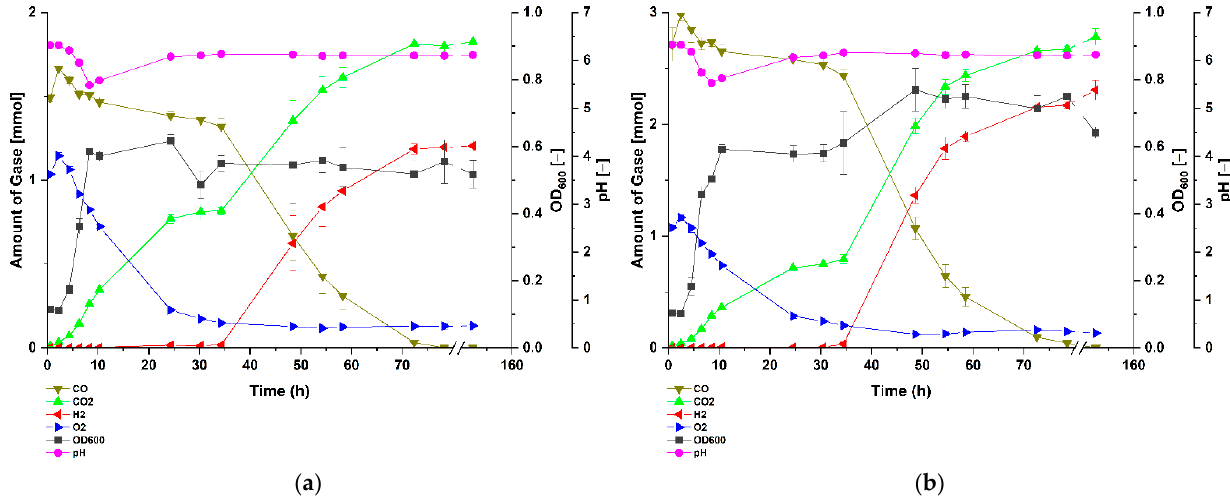
Figure 2. Gas composition and growth of P. thermoglucosidasius DSM 6285 cultivated under ( a ) ~25% and ( b ) ~50% carbon monoxide atmosphere. The strain was grown in stoppered 250 mL serum bottles containing 50 mL of modified ASM medium and an initial O 2 concentration of ~1.2 to 1.4 mmol (40 mL at 1 bar pressure). Reported values represent means of triplicate experiments ± standard deviation.